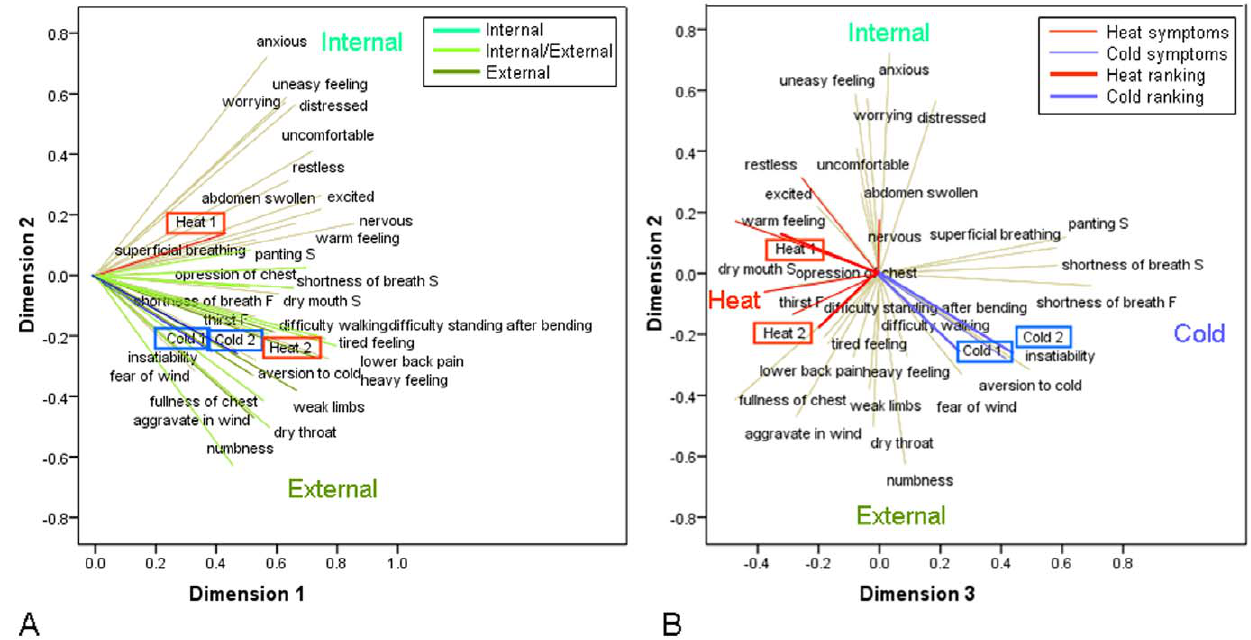
Figure 3. Loading plot of the first two dimensions (panel A) and the second and third dimension (panel B) of the CATPCA model for the 30-variables set. In Panel A, the loading vectors of the symptoms are colored according to their contribution (as indicated by one of the experts) to the Internal or External nature of the disease state. In Panel B, the loading vectors of symptoms which are theoretically related to Cold or Heat are pictured as thin blue or red lines. The supplementary Cold and Heat rankings of the two experts are plotted as thick blue or red lines.